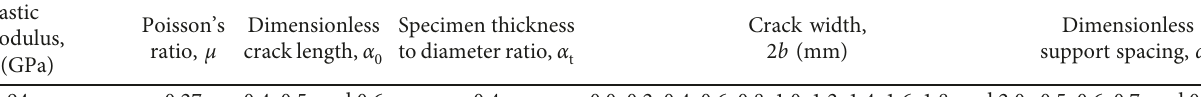
Table 1: NSCB specimen parameters.